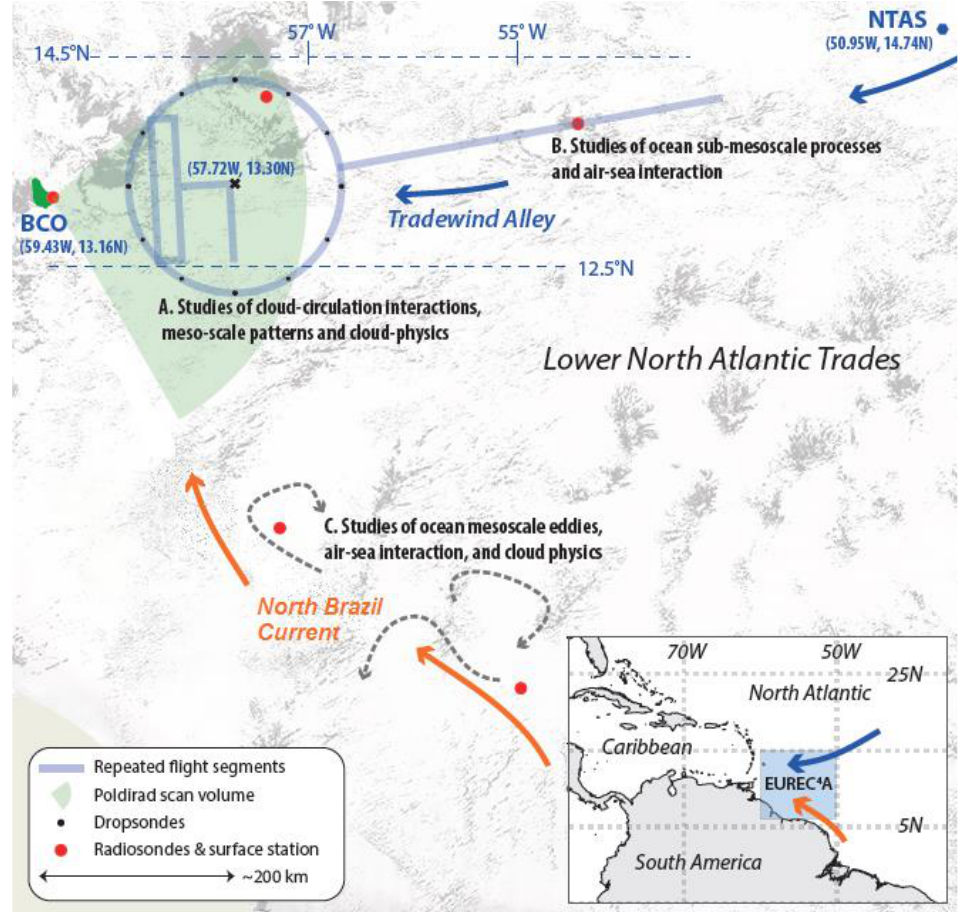
Figure 2. The EUREC 4 A study areas ( A ) located within the “EUREC 4 A-Circle”, ( B ) within the ‘Tradewind Alley” between the Northwest Tropical Atlantic Station (NTAS) and the Barbados Cloud Observatory (BCO) and ( C ) the North Brazil Current region. The inset map shows the location of the EUREC 4 A study area within the Atlantic Ocean. The background cloud field is taken from the 5 February 2020 MODIS-Terra overpass. Reprinted from Stevens et al., 2021